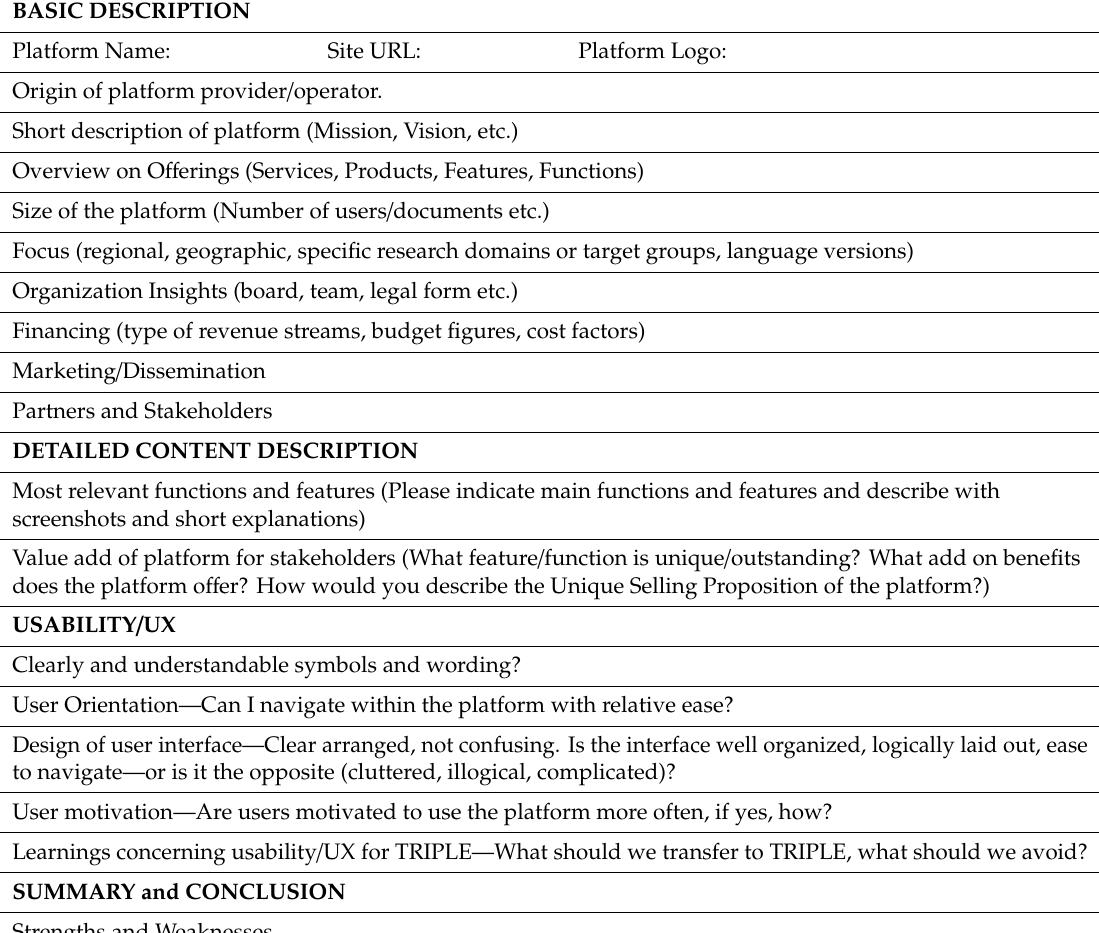
Table 2. Competitor Analysis Template.